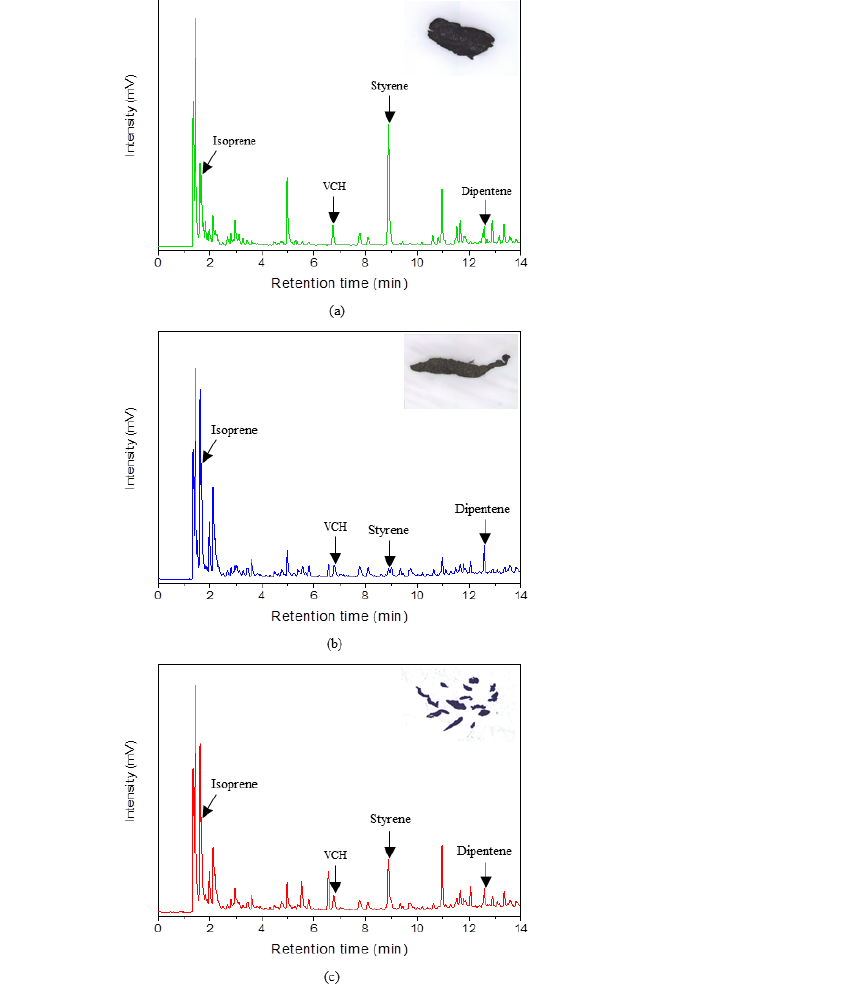
Figure 10. Py-GC chromatograms of the TRWPs classified from the road dust samples. ( a ) the RD2 sample (single TRWP, 1.20–1.30 g/cm 3 ), ( b ) the RD3 sample (single TRWP, 1.40–1.50 g/cm 3 ), and ( c ) the RD4 sample (13 TRWPs, 1.30–1.40 g/cm 3 ).